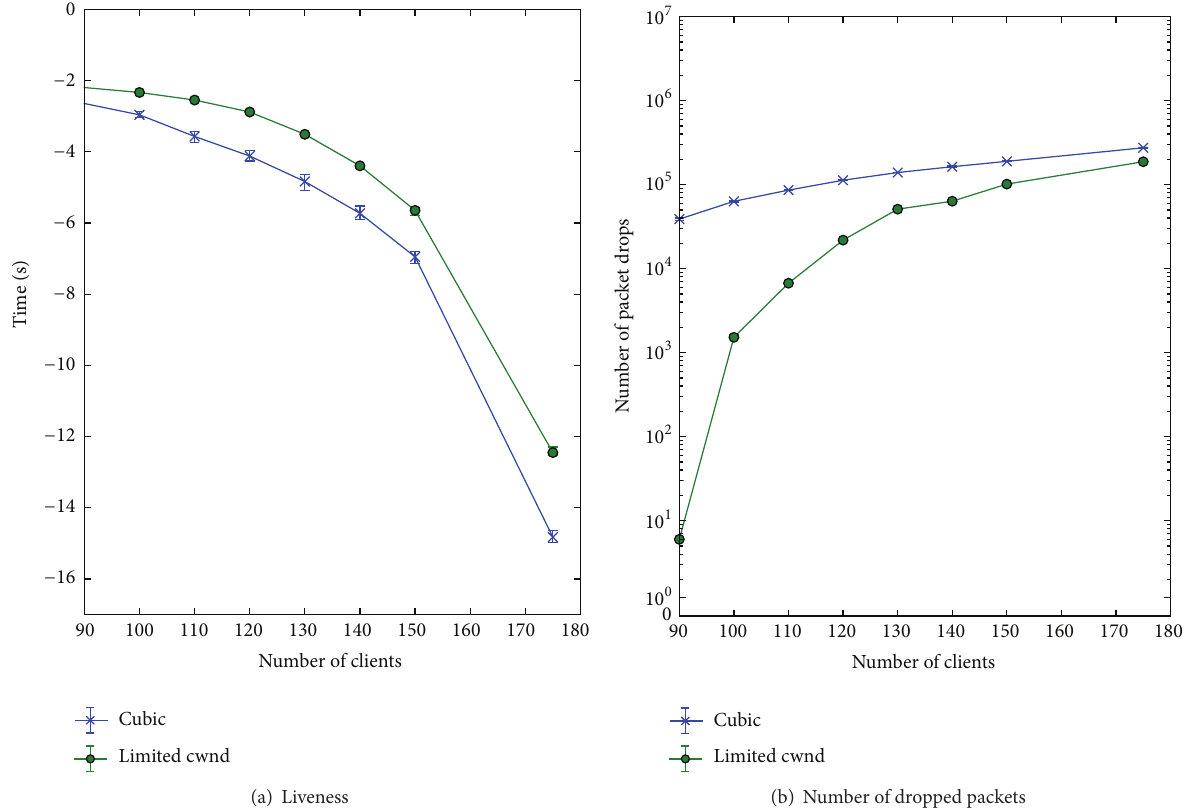
Figure 8: Performance of a limited TCP congestion